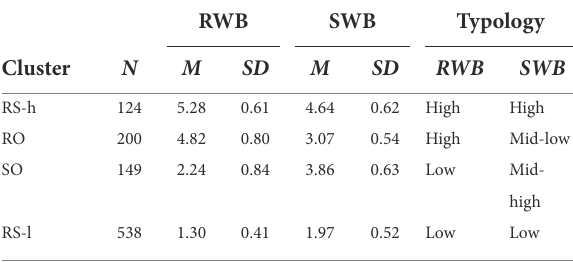
TABLE 2 Profiles for the four-cluster solution of the two-step cluster analysis and a typology of religious and spiritual well-being. RWB SWB Typology Cluster